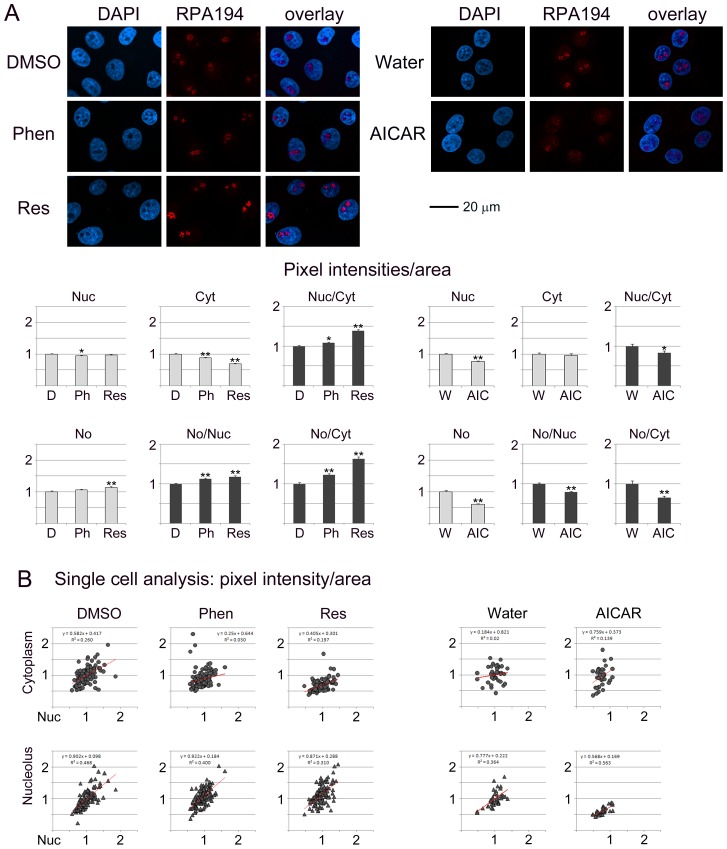
RPA194 subcellular abundance and distribution are modulated by phenformin, resveratrol and AICAR.A detailed description of the experimental set-up and data analyses is provided for Fig. 1.